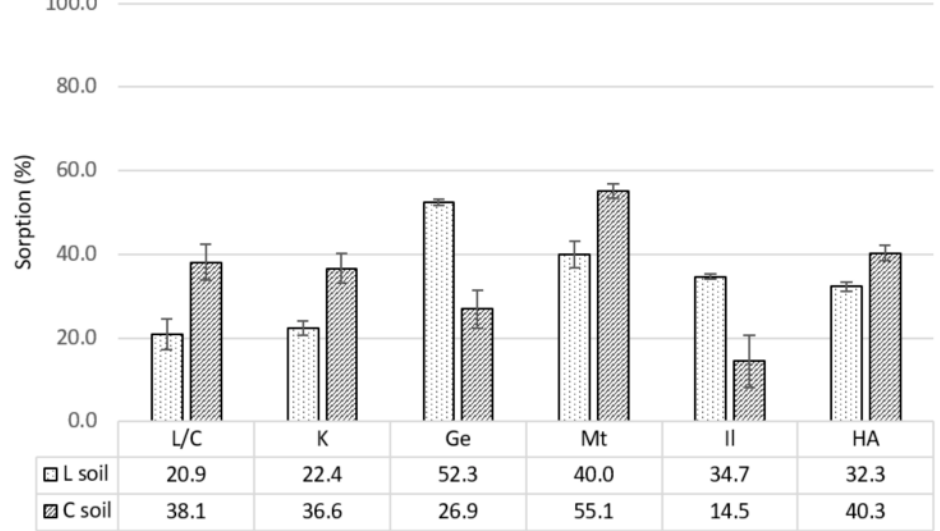
Figure 2. Comparison of carbofuran sorption on soil L and C in the studied variants range. Error bars represent standard deviation of the measurements.